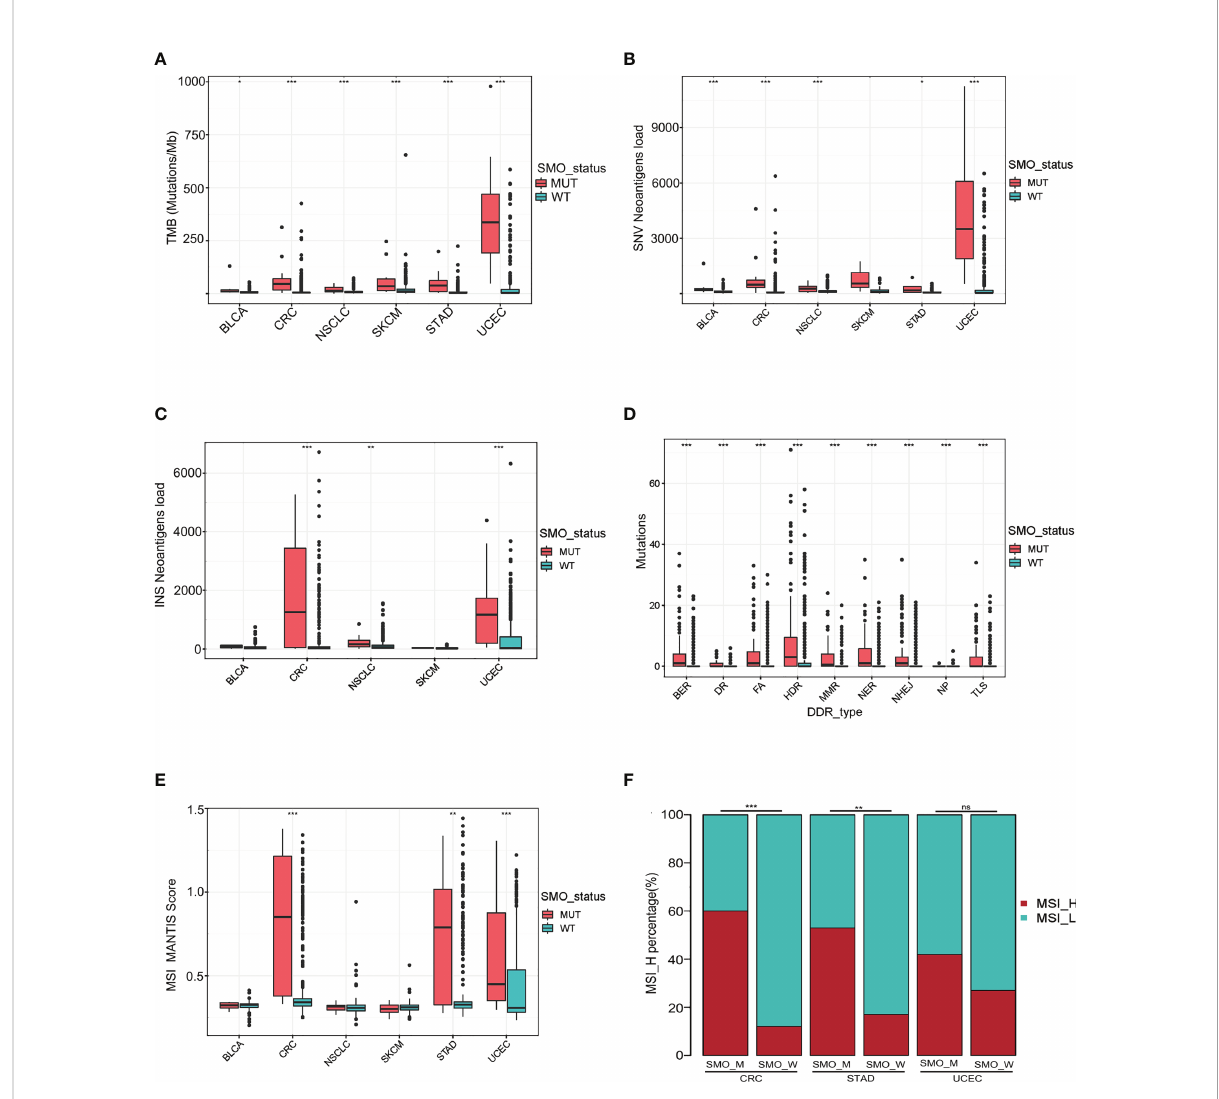
FIGURE 5 Association of SMO mutation with enhanced tumor immunogenicity. (A – C) Box plot depicting the distributions of tumor mutation burden (TMB), single nucleotide variant (SNV) neoantigen load, and insertion – deletion (INDEL) neoantigen load in SMO mutant (SMO_MUT) and SMO wild-type (SMO_WT) tumors in The Cancer Genome Atlas (TCGA) cohort (two-tailed Mann – Whitney U test). (D) Mutation rates of the DNA damage repair (DDR) pathway genes between the SMO mutant (SMO_MUT) and wild-type (SMO_WT) subgroups in the TCGA cohort (two-tailed Mann – Whitney U test). (E) Box plot depicting the distribution of the microsatellite instability (MSI) scores in SMO_MUT and SMO_WT tumors in the TCGA cohort (two-tailed Mann – Whitney U test). (F) MSI-H percentages in SMO_MUT or SMO_WT samples in colorectal cancer (CRC), stomach adenocarcinoma (STAD), and uterine corpus endometrial carcinoma (UCEC; two-tailed Fisher ’ s exact test). * p < 0.05, ** p < 0.01, *** p < 0.001. ns, no signi fi